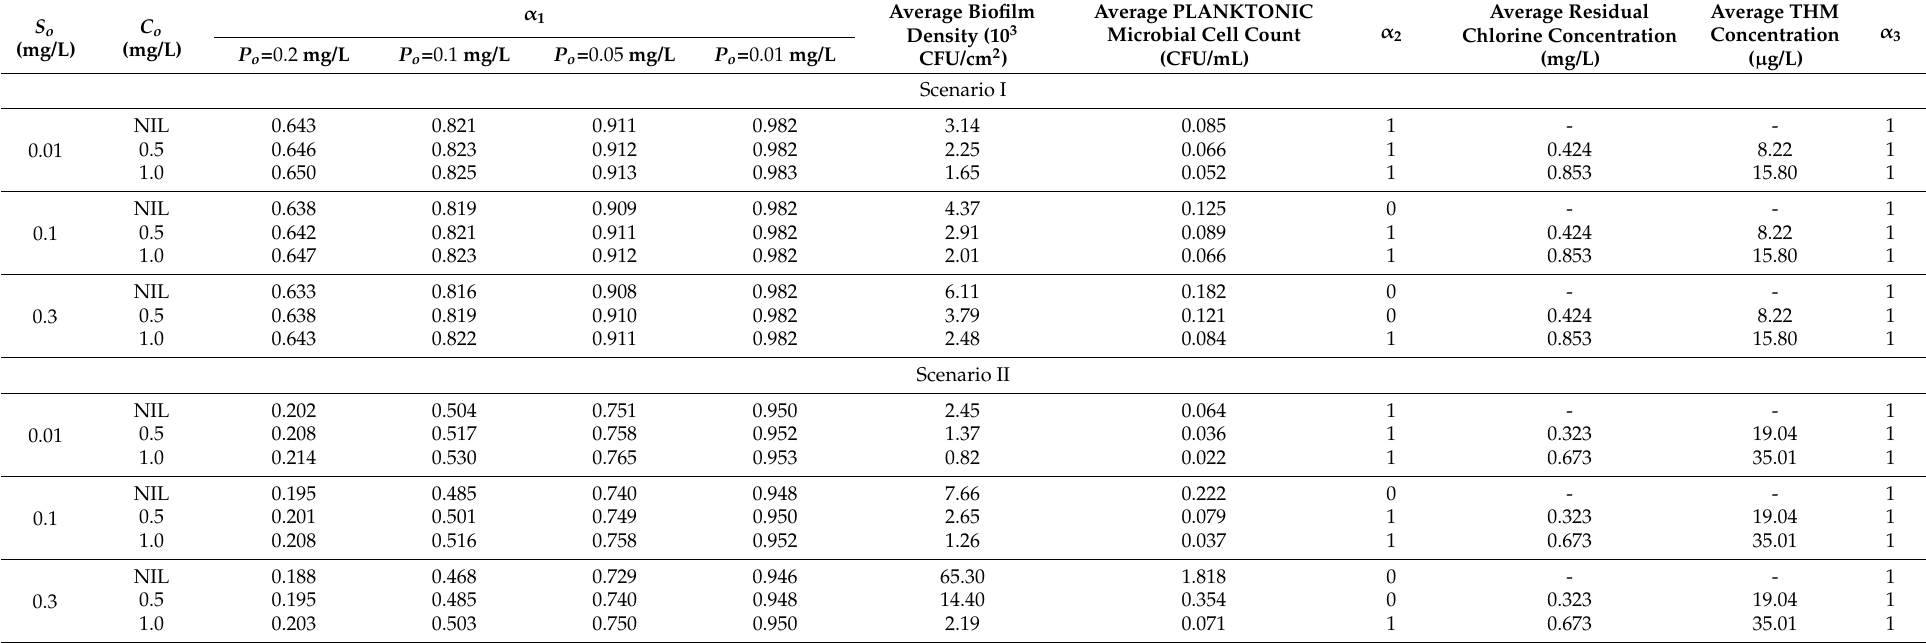
Table 4. Balerma network simulation results under = 25 ◦